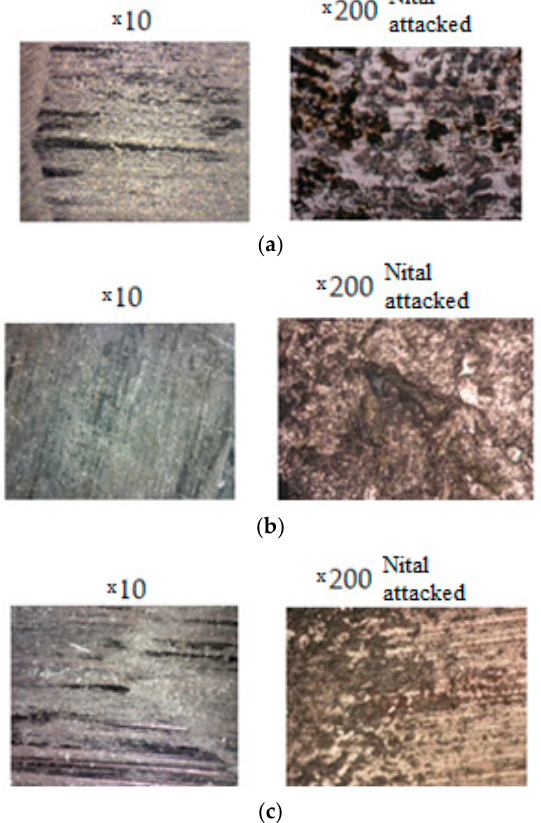
Figure 12. The surface aspect of the samples at the end of the second test program: ( a ) sample 1.2/2; ( b ) sample 2.2/2; and ( c ) sample 3.1/2.